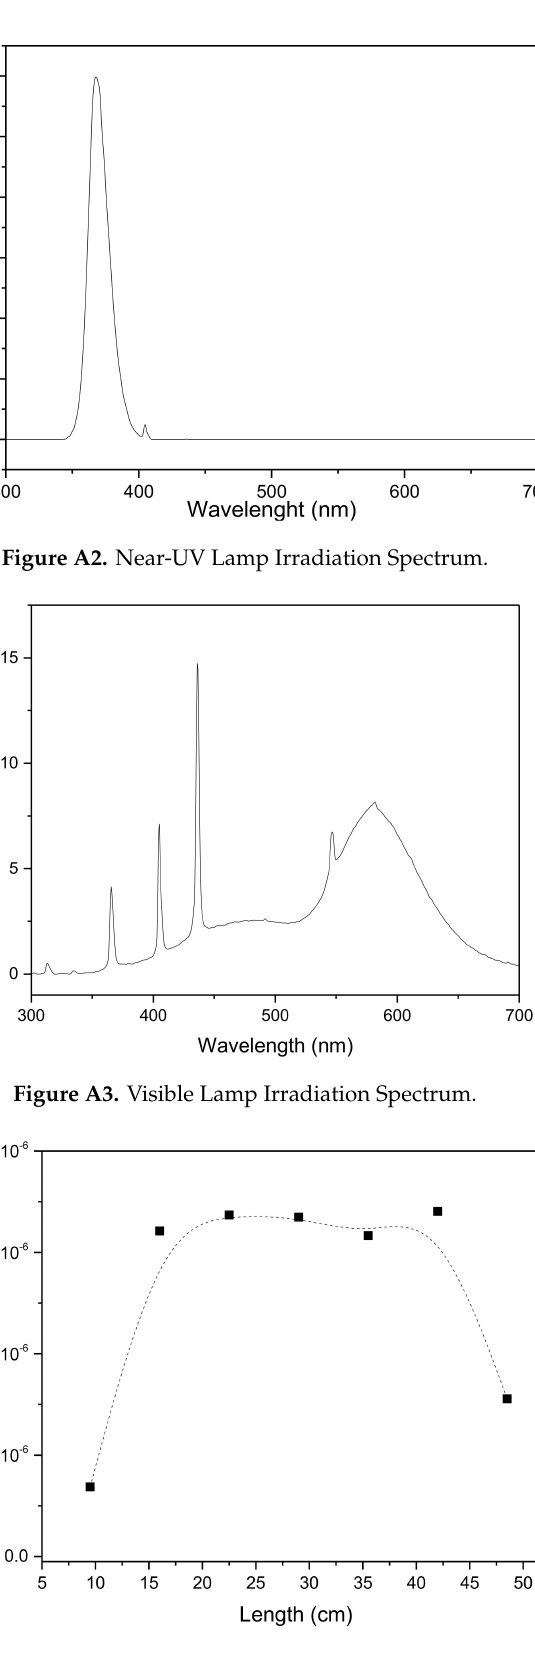
Figure A4. Visible Lamp Axial